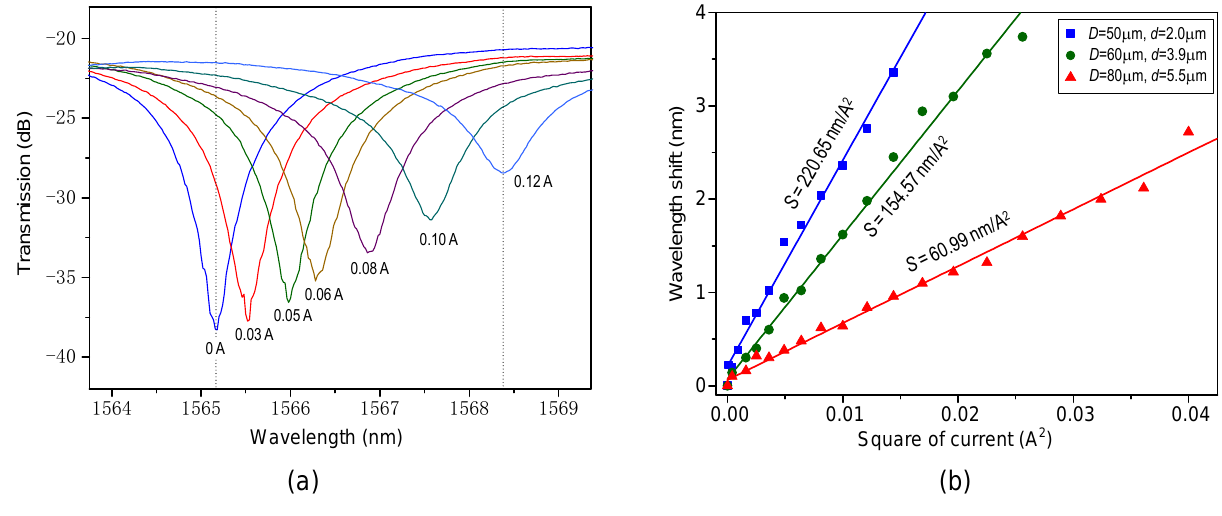
Figure 3. ( a ) Variation of transmission spectrum with the change of the carried current. The resonant wavelength shifts from 1,565.2 nm to 1,568.4 nm when the current varies from 0 A to 0.12 A; ( b ) Dip wavelengths as functions of the square of current for the different component sizes. The points are experimental values and the solid lines are linear fitting